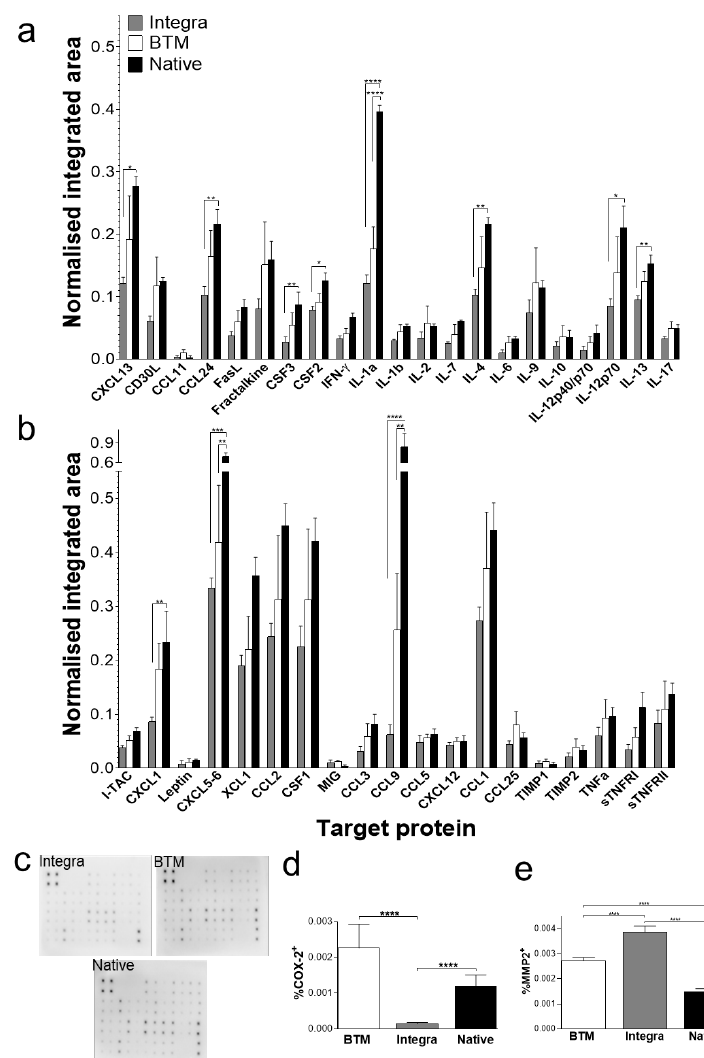
Figure 4. Protein expression profiling of 2-week-long grafts. ( a and b ) Protein signals recorded for each target using 10-second exposure and normalised to positive controls. Mean and SEM values presented for each target ( n = 4 per group) ( a ) Targets from rows 1 and 2 position F6 to rows 5 and 6 position B2 of the array). ( b ) Targets from rows 5 and 6 position B3 to rows 7 and 8 position I9 of the array. The full map of the array is provided in Supplementary Data Table S1. ( c ) Representative chemiluminescent protein array blots for each group. ( d ) Quantification of immunoperoxidase staining for inflammation marker, COX-2 ( n = 4–8 mice per group), using unpaired t-test * = p < 0.05, ** = p < 0.01, *** = p < 0.001, **** = p < 0.0001. ( e ) Quantification of immunoperoxidase staining for ECM remodelling enzyme, MMP-2 ( n = 4–8 mice per group). Results analysed using unpaired t-test, significant p -values as for panel c. Abbreviations: CCL1 (TCA-3), chemokine CC motif ligand 1; CCL2 (MCP-1),